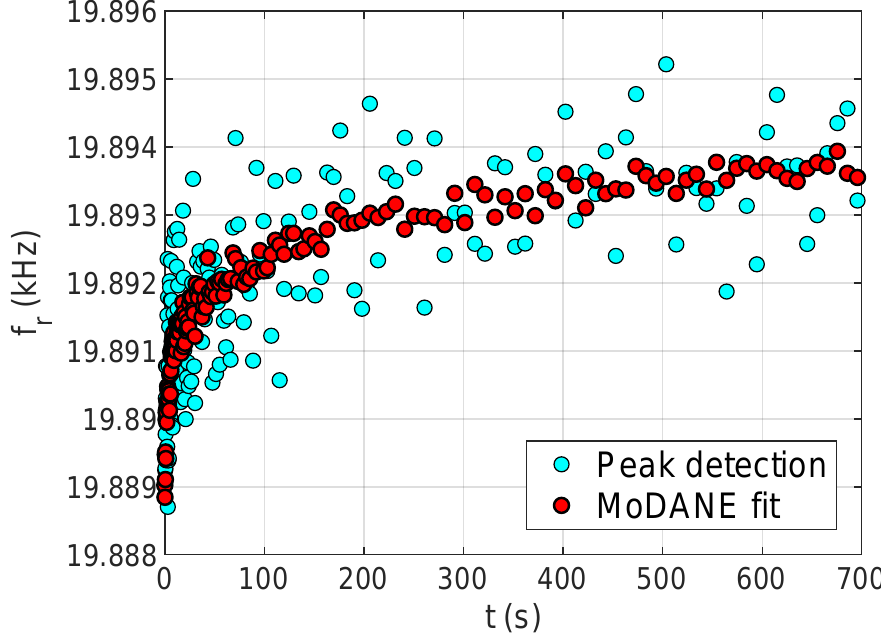
Figure 4. Reliability and accuracy of the proposed approach. Experimental resonance curves (see Figure 3 for an example) have been treated to detect the resonance frequency: Red symbols refer to the resonant frequencies detected using the MoDaNE approach (used to treat the data in our work); cyan symbols refer to peak picking of the resonance frequency using a quadratic fit of the data in a narrow region around the maximum (standard approaches). Results are equivalent but the MoDaNE approach is significantly less